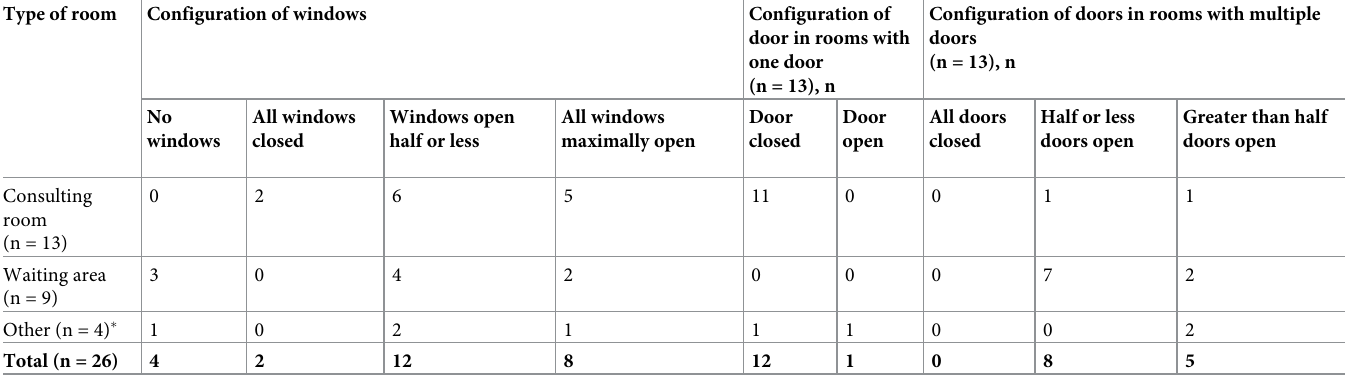
Table 2. The configuration of windows and doors under usual conditions in rooms where tracer gas release experiments were performed (n = 26 experiments on 12 days). Type of room Configuration of